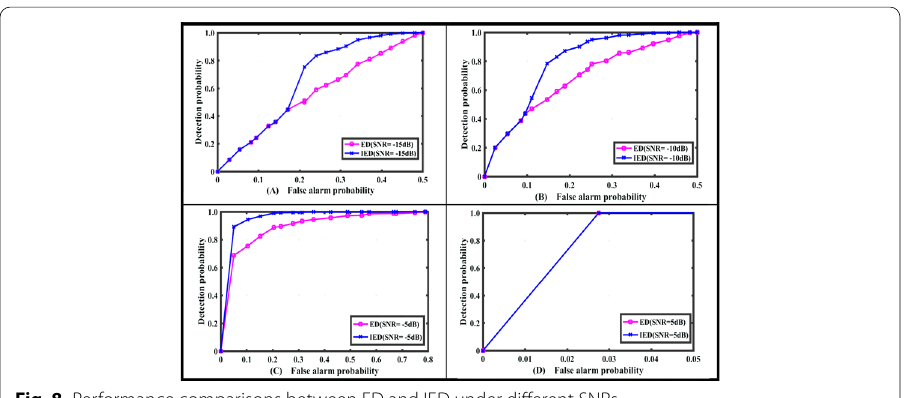
Fig. 8 Performance comparisons between ED and IED under different